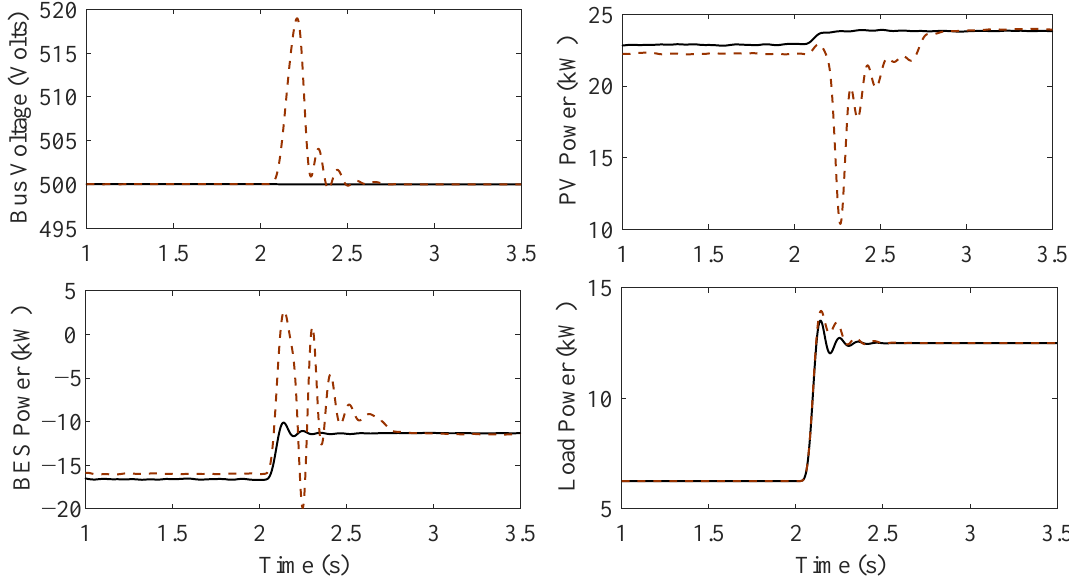
Figure 7. Bus voltage and different power responses under load variation. Table 3. Quantitative comparison between proposed and existing controller under load